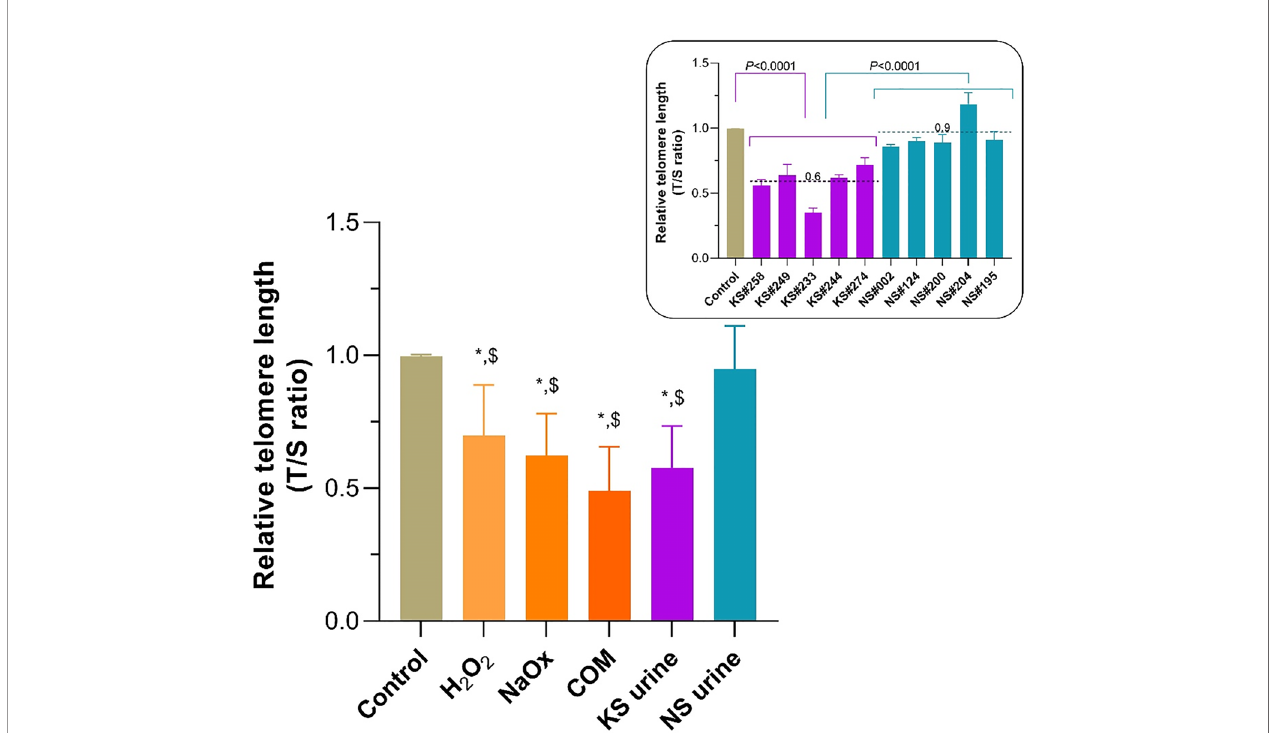
FIGURE 4 | Shortening of telomeric length in HK-2 cells treated with sodium oxalate (NaOx), calcium oxalate monohydrate (COM), and urine from patients with KS (KS urine). The relative telomere length (RTL) was signi fi cantly reduced in HK-2 cells treated with NaOx, COM, or KS urine compared with the length in untreated control cells or those treated with urine from donors without KS (NS urine). In all instances KS urine reduced the RTL to almost half of that of the controls, and the extent of shortening was greater than after treatment with NS urine (inset). Dashed line and number indicate mean. Error bars indicate SEM of at least triplicate treatments. * P < 0.05 vs. Control, $ P < 0.05 vs. NS